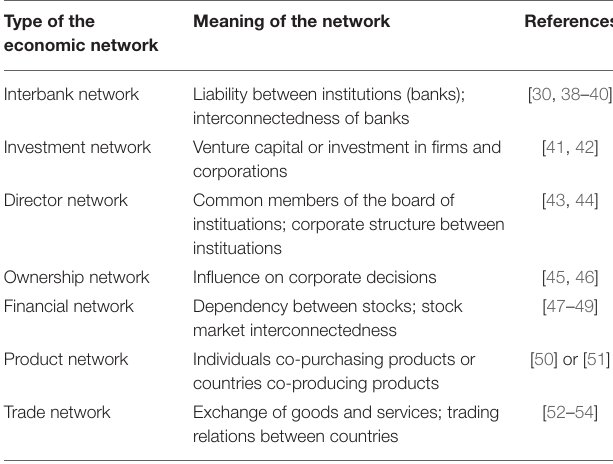
TABLE 1 | Examples of different types of economic networks that have been frequently studied in the